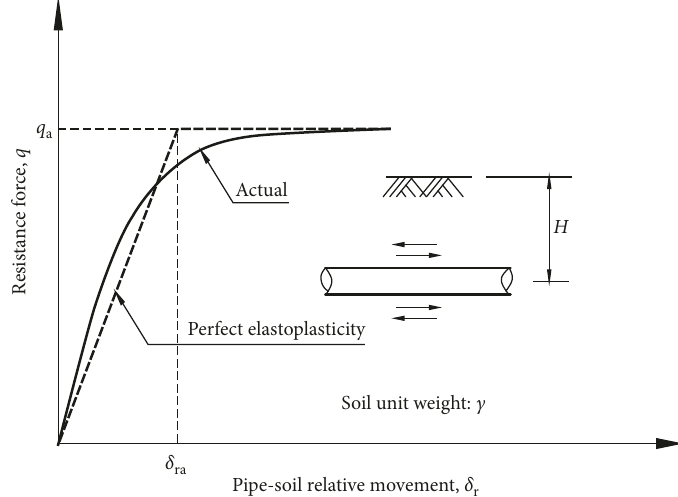
Figure 2: Force-axial relative displacement response in pipe-soil